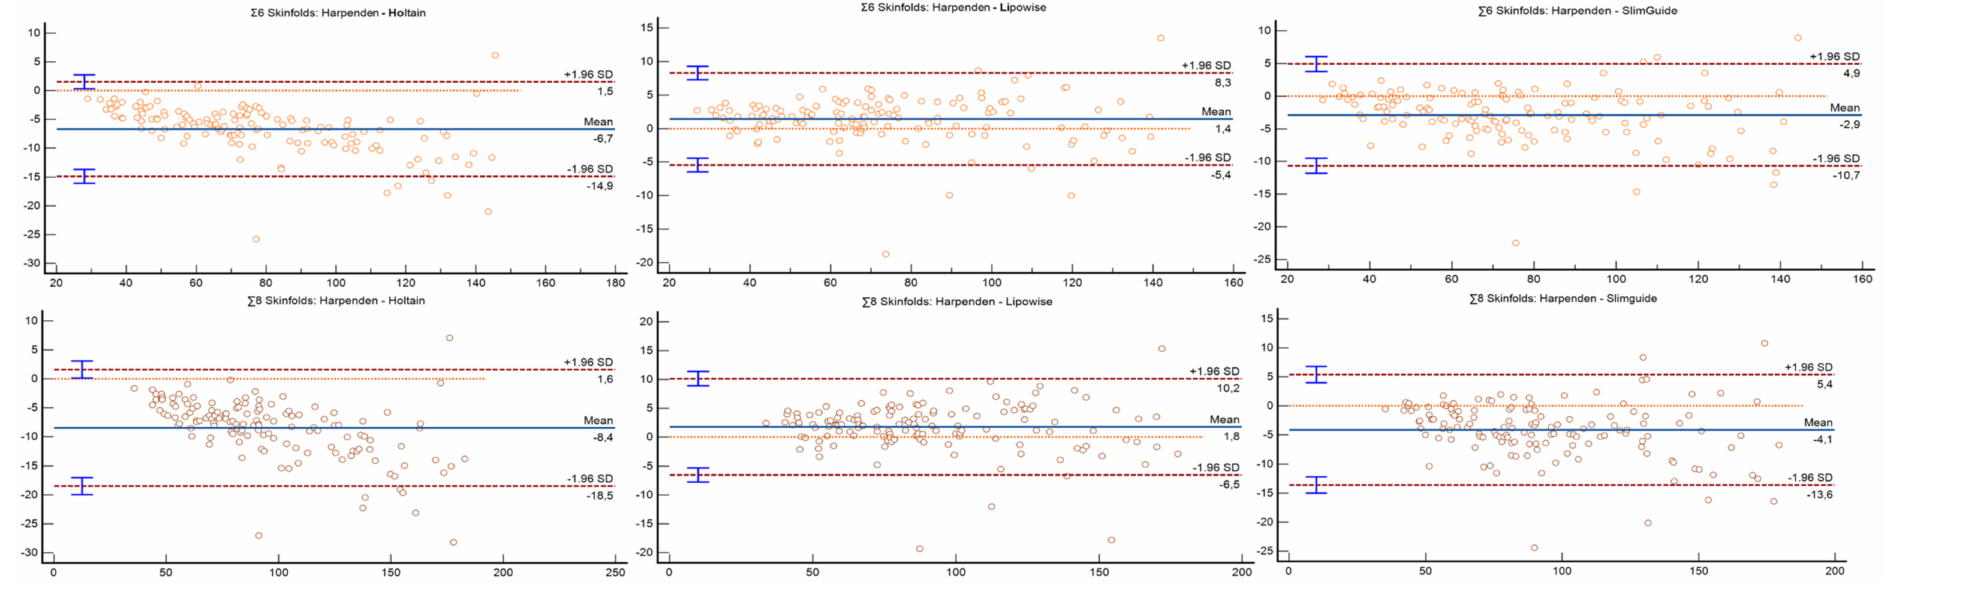
Figure 1. Bland–Altman plot for the 6 and 8